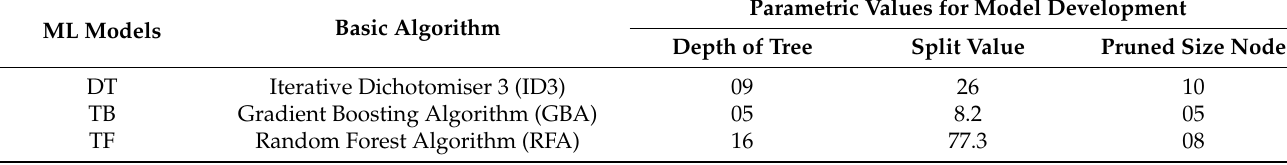
Figure 3. Stepwise process for tree-based ML models on ET o modeling. Table 2. Outline of tree-based ML models.